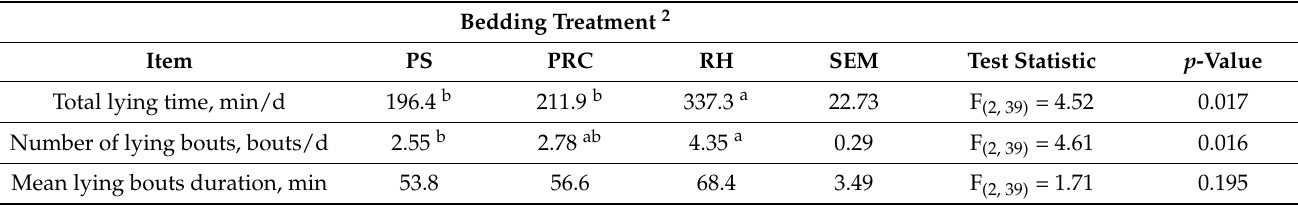
Table 4. Total lying time, the number of lying bouts, and mean duration of lying bouts for the three bedding treatments during the preference test 1